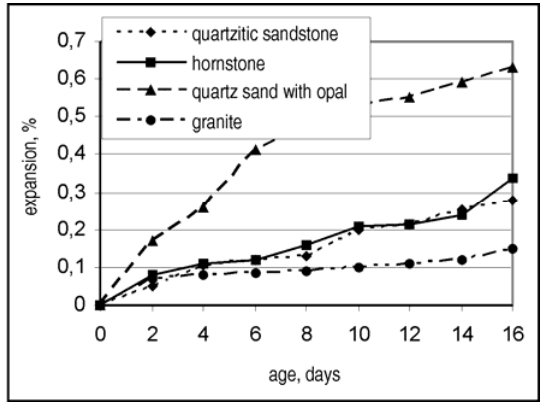
Fig 3. Expansion of mortar bars containing quartzitic sandstone, hornstone, quartz sand with opal and granite aggregate (ASTM C 1260 test)